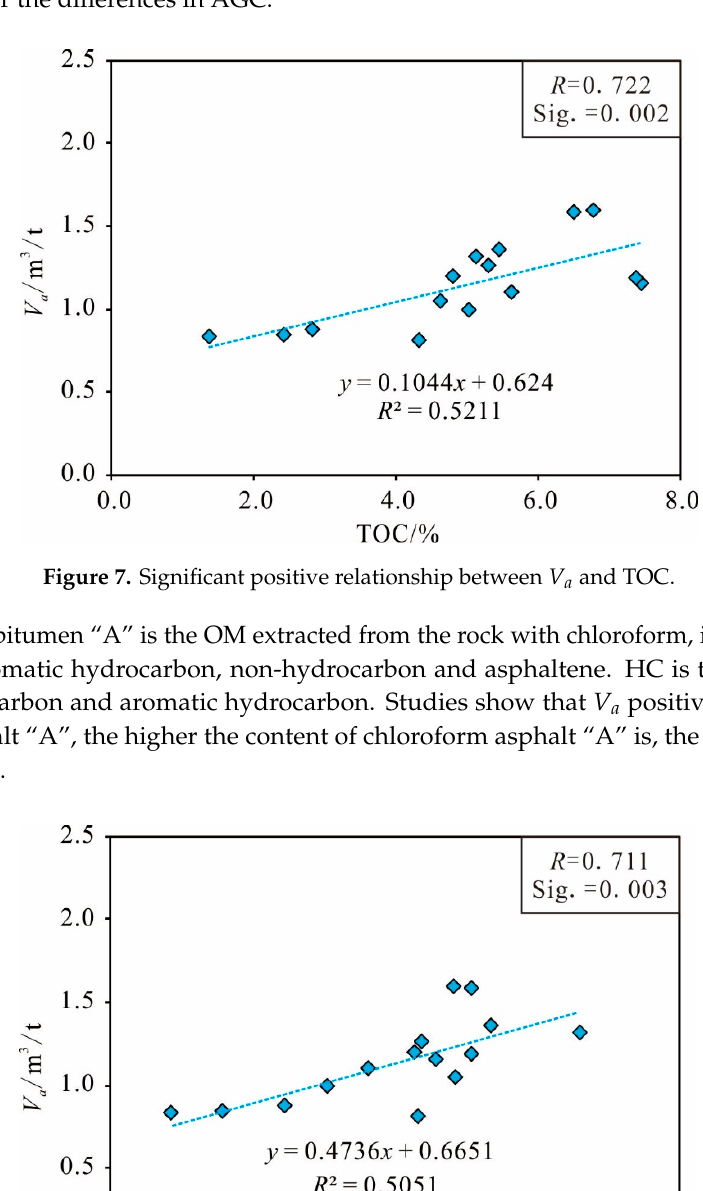
Figure 8. Significant positive relationship between V a and chloroform asphalt "A".